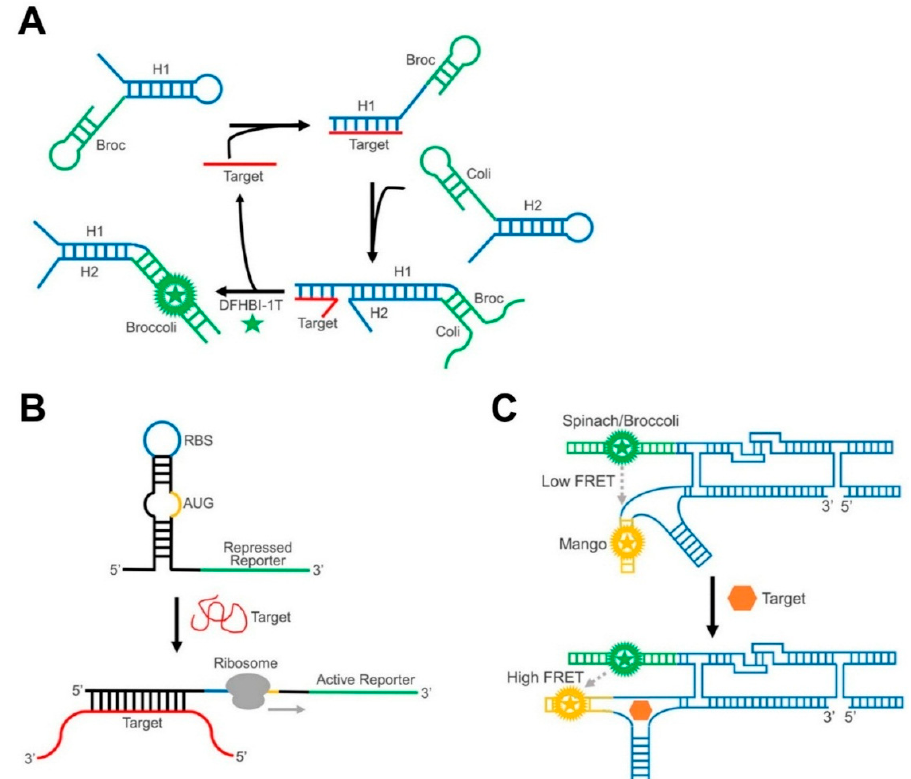
Figure 4. Schematics of RNA nanotechnology-inspired GERMS. ( A ) In a CHARGE circuit, target binding (red) induces the catalytic hybridization of multiple hairpin assemblies (blue), further activating an amplified signal from reassembled Broccoli RNA (green). ( B ) In a toehold switch sensor, target binding releases the ribosome binding site (RBS) and a start codon (AUG), which activates the expression of the reporting system (green). ( C ) In an RNA origami construct, target-induced structure change can regulate the distance and FRET efficiency between two fluorogenic RNA complexes.